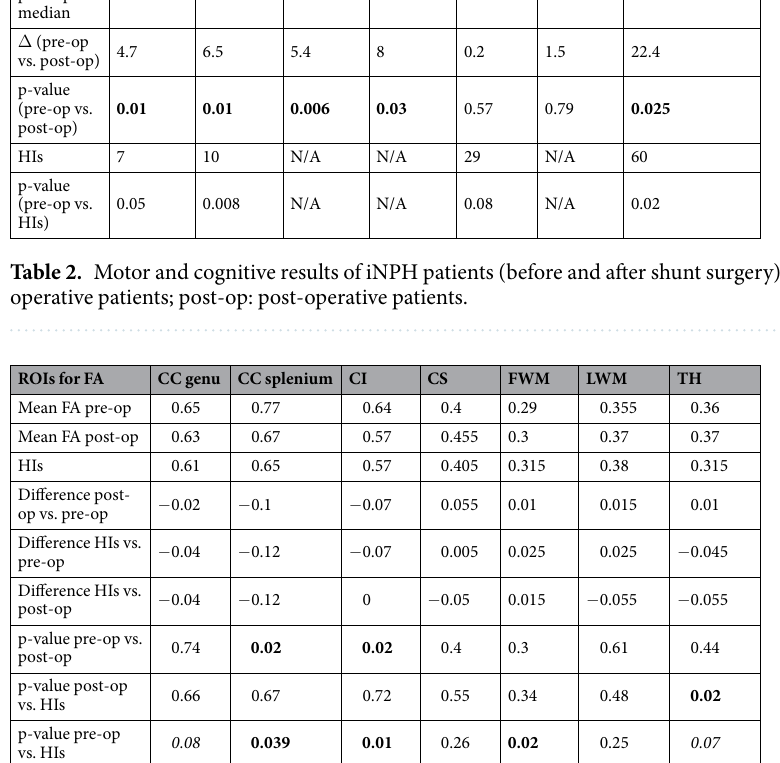
Table 3. FA values of pre- and post-operative patients and HIs, with statistical analysis.